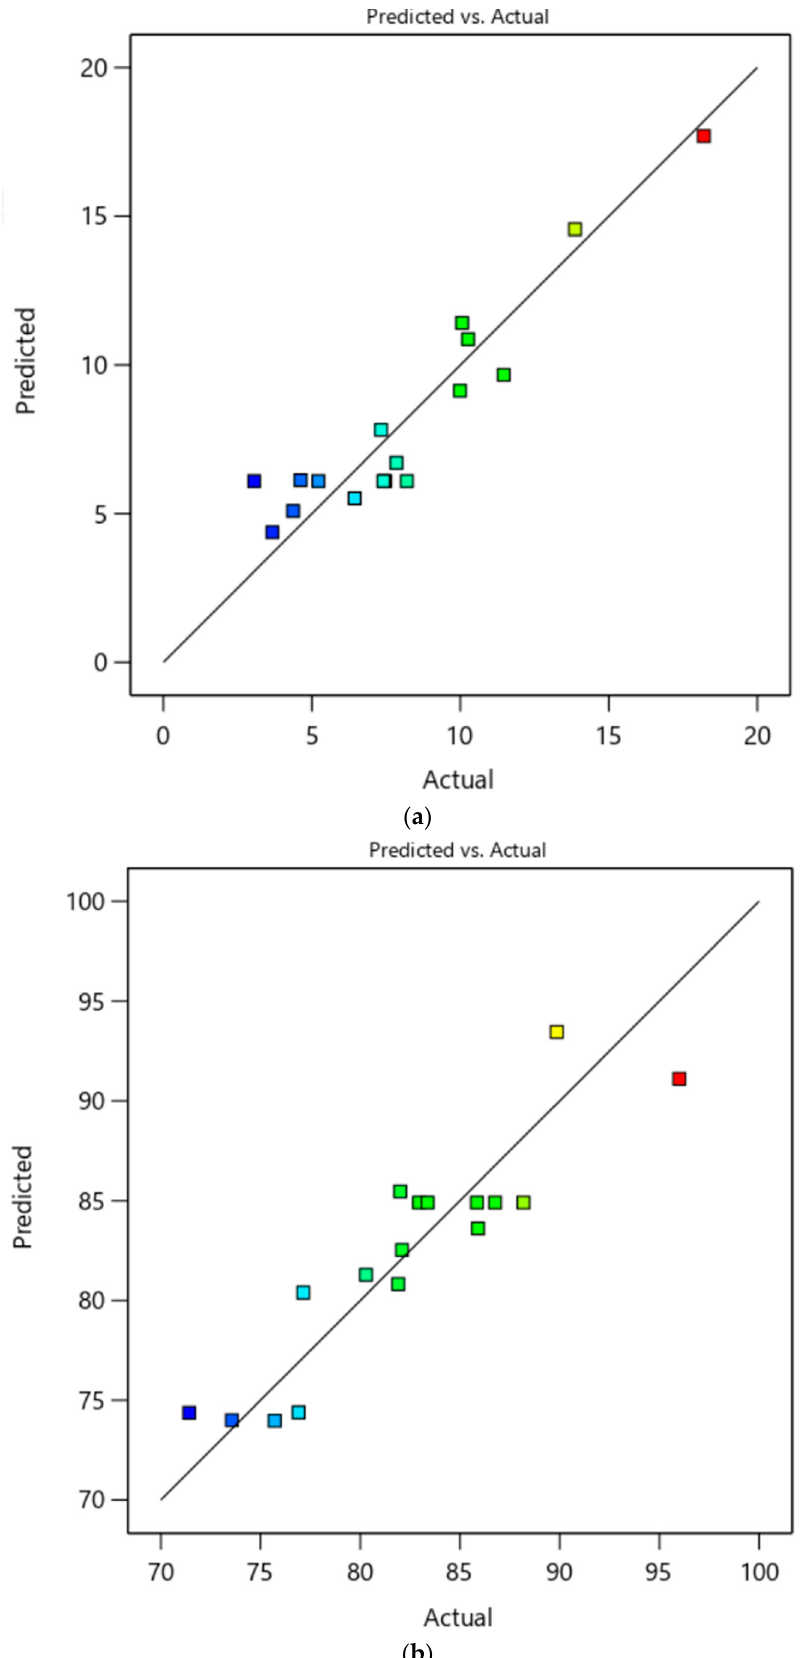
Figure 1. Predicted vs. Actual responses: ( a ) Yield, and ( b ) TPC for ScCO 2 extraction.